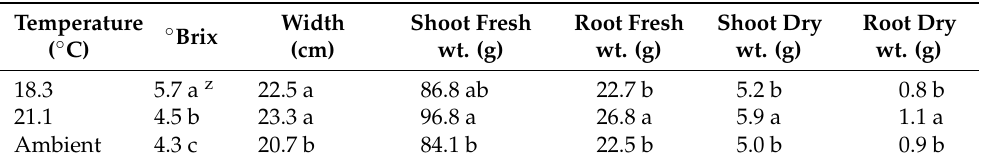
greatest root weight but was not different from all other cultivars except “Oakleaf Green”, “Oakleaf Red”, and “Butter” (Table 4). “Optima” had the greatest root dry weight and was similar “Oakleaf Green”, “Oakleaf Red”, “Sweet Crisp Green”, and “Butter” (Table 4). For shoot fresh weight, “Coastal Star” and “Sweet Crisp Green” were greatest but not different than all other cultivars except “Panisse”, “Oakleaf Green”, “Oakleaf Red”, and “Butter”. Within Loose-leaf type, “Black Seeded Simpson” and “Waldman’s Dark Green” had greater fresh and dry shoot weight compared to “Panisse”. Table 3. Least square means for water temperature on growth and ◦ Brix of five types of lettuce grown in NFT hydroponic systems at the OSU research greenhouses, Stillwater, OK, USA. Shoot Fresh Root Fresh Shoot Dry Root Dry Temperature ◦ Brix Width (cm) wt. (g) wt. (g) wt. (g) wt. (g) ( ◦ C)